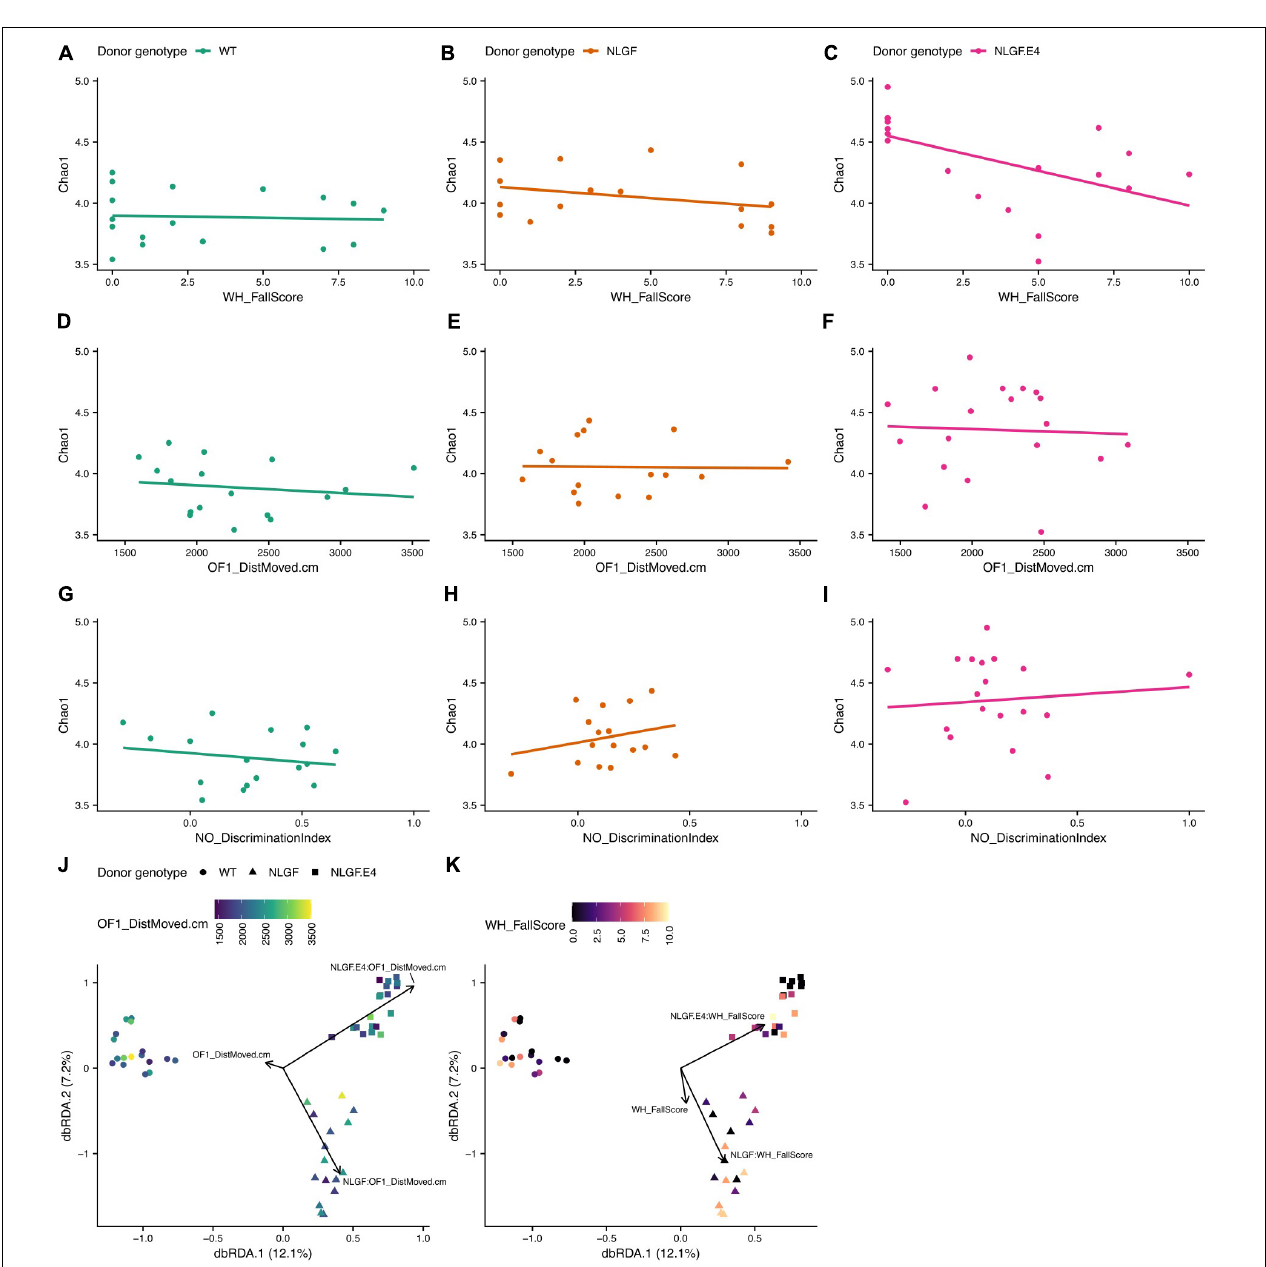
FIGURE 7 | Alpha- and beta-diversity scores of recipient samples by behavior scores and donor genotype. (A–C) Chao1 index scores by WH_FallScore for samples with microbiomes transplanted from WT (A) , App NL − G − F , (B) , or App NL − G − F / E4 (C) mice. (D–F) Chao1 index scores by OF1-DistMoved.cm for recipients of microbiome transplants from each donor genotype, same order as (A–C) . (G–I) Chao1 index scores by NO_DiscriminationIndex for recipients of microbiome transplants from each donor genotype, same order as (A–C) . (J) dbRDA ordination of Canberra distances of differences in composition between samples. The shape of the point indicates the donor genotype and the color of the point indicates the OF1_DistMoved.cm score for that sample. The black arrows indicate that the direction of greatest change for the OF1_DistMoved.cm score interacts significantly with the genotype of the donor that provided the microbiome transplant. (K) dbRDA ordination [exact same ordination as in J] of Canberra distances of differences in composition between samples. The shape of the point indicates the donor genotype and the color of the point indicates the WH_FallScore for that sample. The black arrows indicate that the direction of greatest change for the WH_FallScore score interacts significantly with the genotype of the donor that provided the microbiome transplant.